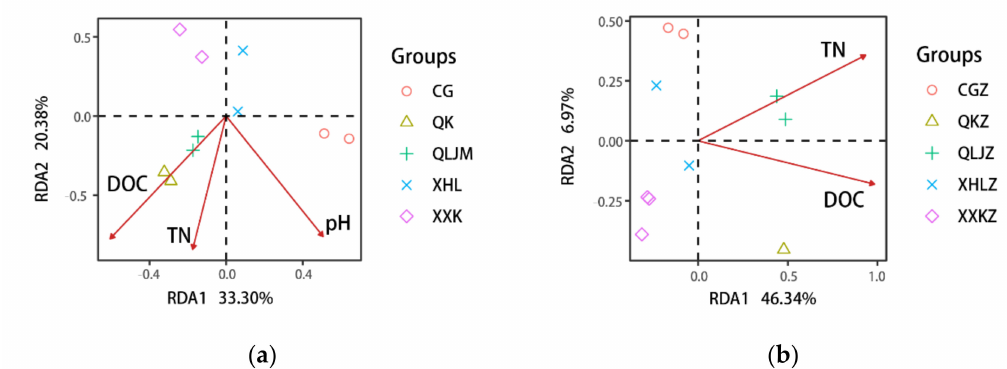
Figure 5. Relationship between microbial communities and environmental factors respectively associated with Moina ( a ) and Calanoids ( b ). Each symbol shows the sum of 13 − 15 individuals from each sample in each lake. Each significant factor ( p < 0.05) was shown in the plot with red arrows. TN, total nitrogen; DOC, dissolved organic carbon.